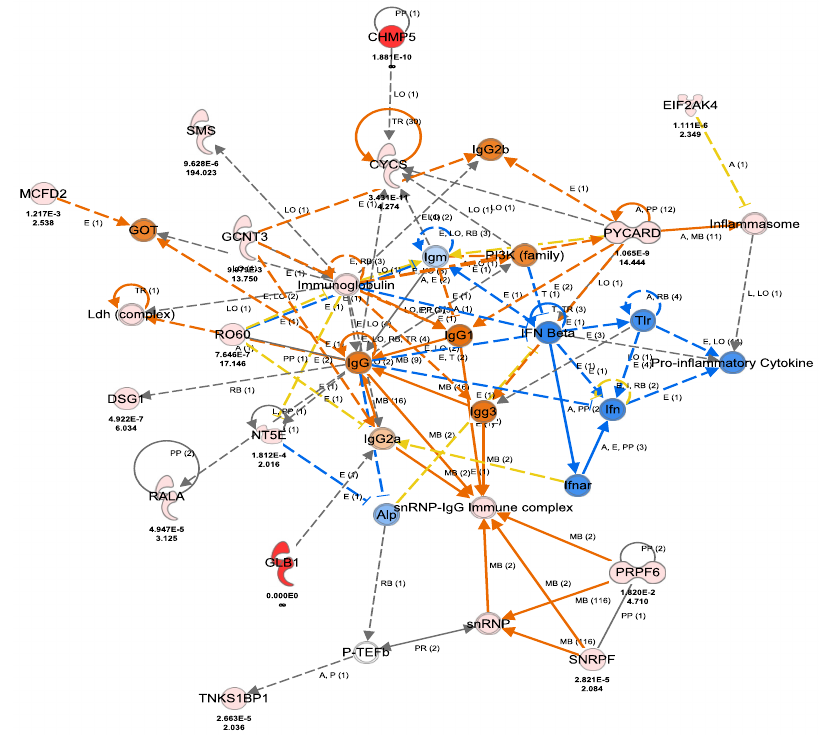
Figure 10. Ingenuity pathway analysis (IPA) of differential proteins linked with inflammatory re- sponse, immune complex and cytokines/inflammasome. The figure was generated using a licensed Ingenuity pathway analysis program (www.qiagen.com, accessed on 15 May